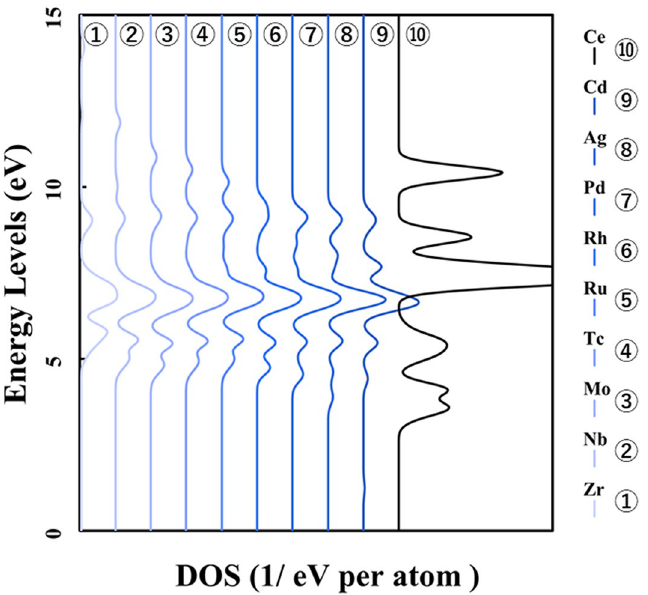
Figure 3. p-DOS for the 2p orbitals of the oxygen atoms in the M@Ce 12 O 8 36+ cluster model, the vacuum level is the reference energy level (M = Zr, Nb, Mo, Tc, Ru, Rh, Pd, Ag, Cd, Ce).